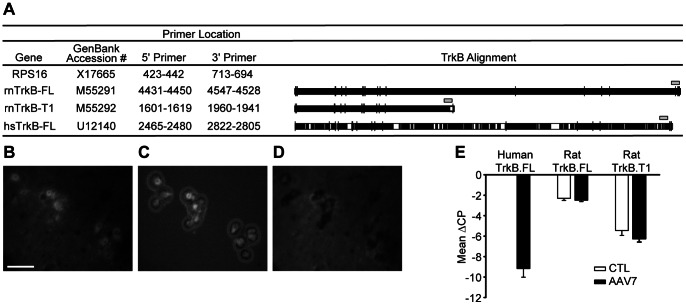
Delivery of intrapleural AAV7-TrkB.FL to phrenic motoneurons, detected by TrkB mRNA expression in microdissected motoneurons.A) Sequence alignment for TrkB receptor mRNA. White areas display regions of mismatch across all 3 mRNA transcripts. Primers used for amplification of TrkB receptor mRNA using quantitative real-time RT-PCR in microdissected phrenic motoneurons are shown above each sequence (gray box). Laser capture microdissection (LCM) was utilized to individually capture phrenic motoneurons. Representative photomicrographs display the LCM procedure. B) Retrogradely-labeled phrenic motoneurons by intrapleural injection with Alexa Fluor 488-conjugated cholera toxin subunit B. C) Selective capture of phrenic motoneurons on the LCM cap. D) Lack of Alexa 488 fluorescence reveals complete capture of selected phrenic motoneurons; Bar, 100 µm in B-D. E) Human TrkB.FL mRNA expression as well as rat TrkB.FL and rat truncated TrkB (TrkB.T1) mRNA transcripts were assessed in microdissected phrenic motoneurons 5 weeks after intrapleural injection with either saline (CTL; n = 3) or AAV7-TrkB.FL (AAV7; n = 3) in control, uninjured animals. Results of duplicate RT and real-time PCR reactions were clustered by animal after obtaining the crossing point difference (ΔCP) from RPS16, and thus reflect the relative mRNA concentration in each sample. Data are mean ± SE of ΔCP across animals.